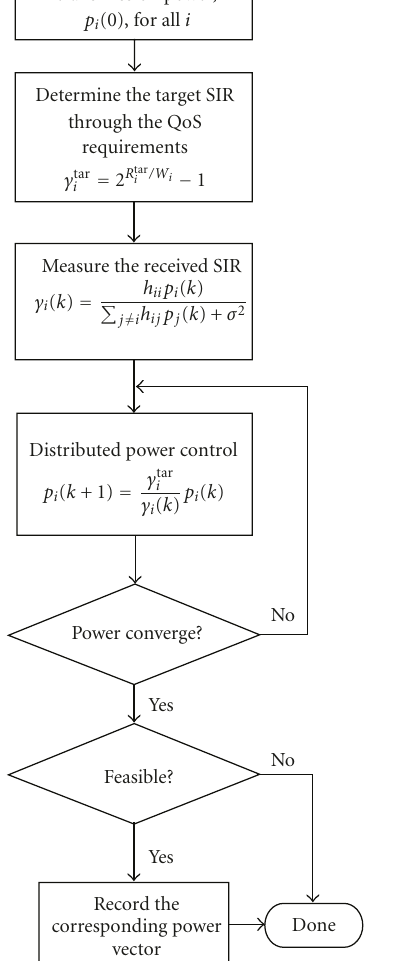
Figure 2: Distributed algorithm for power-controlled connectivity graph.